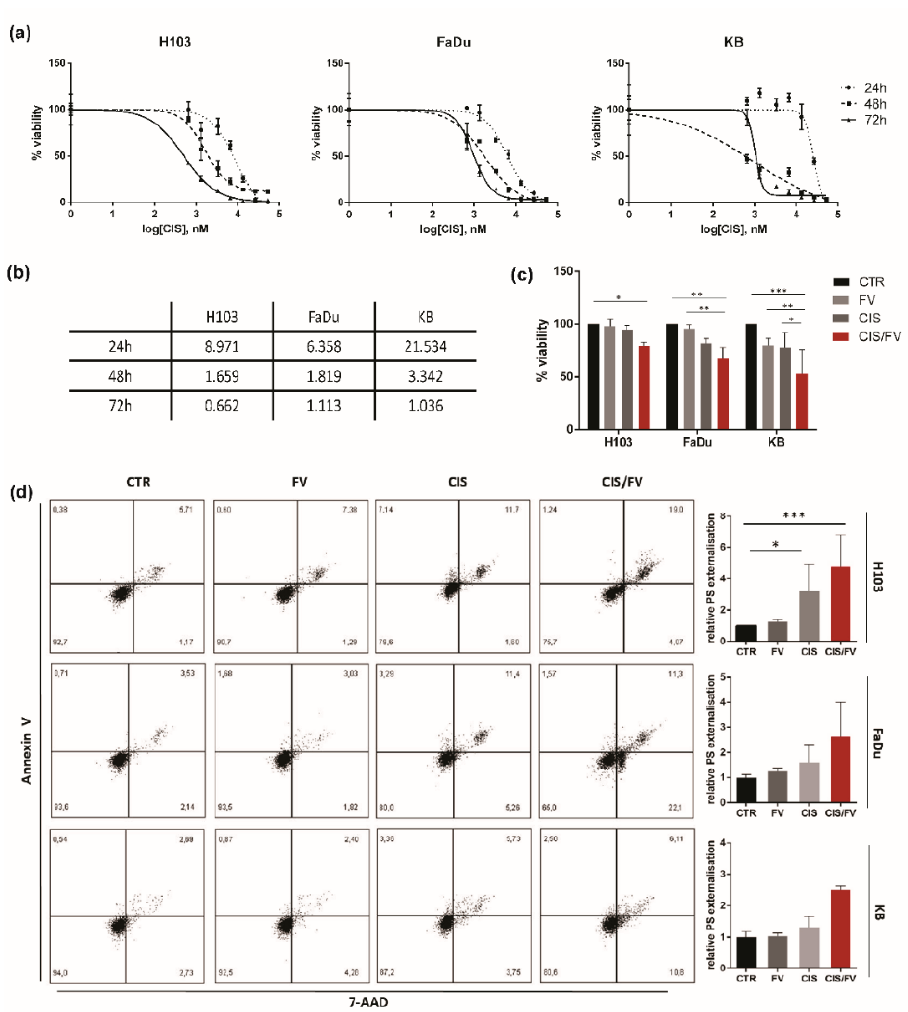
Figure 5. Simultaneous co-administration of cisplatin and fucoidan on HNSCC cell lines: H103, FaDu,